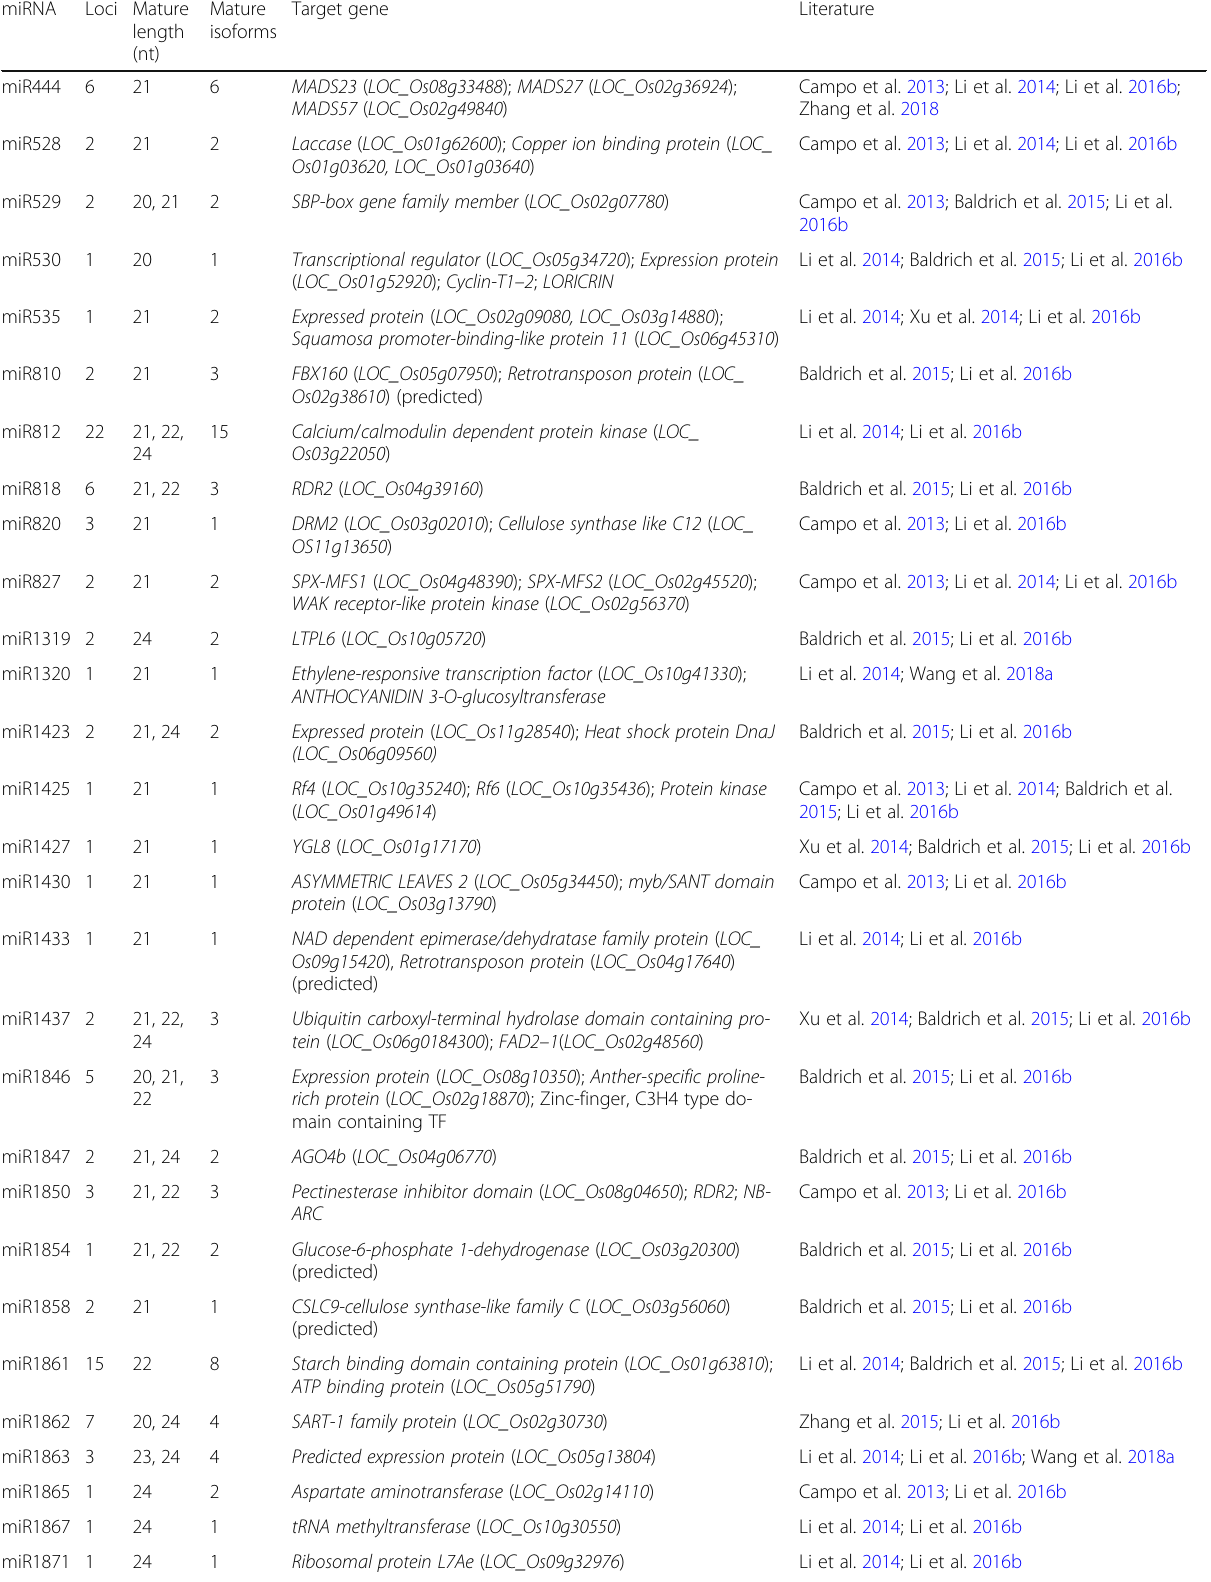
Table 1 miRNAs responsive to Magnaporthe oryzae or its elicitors a (Continued)